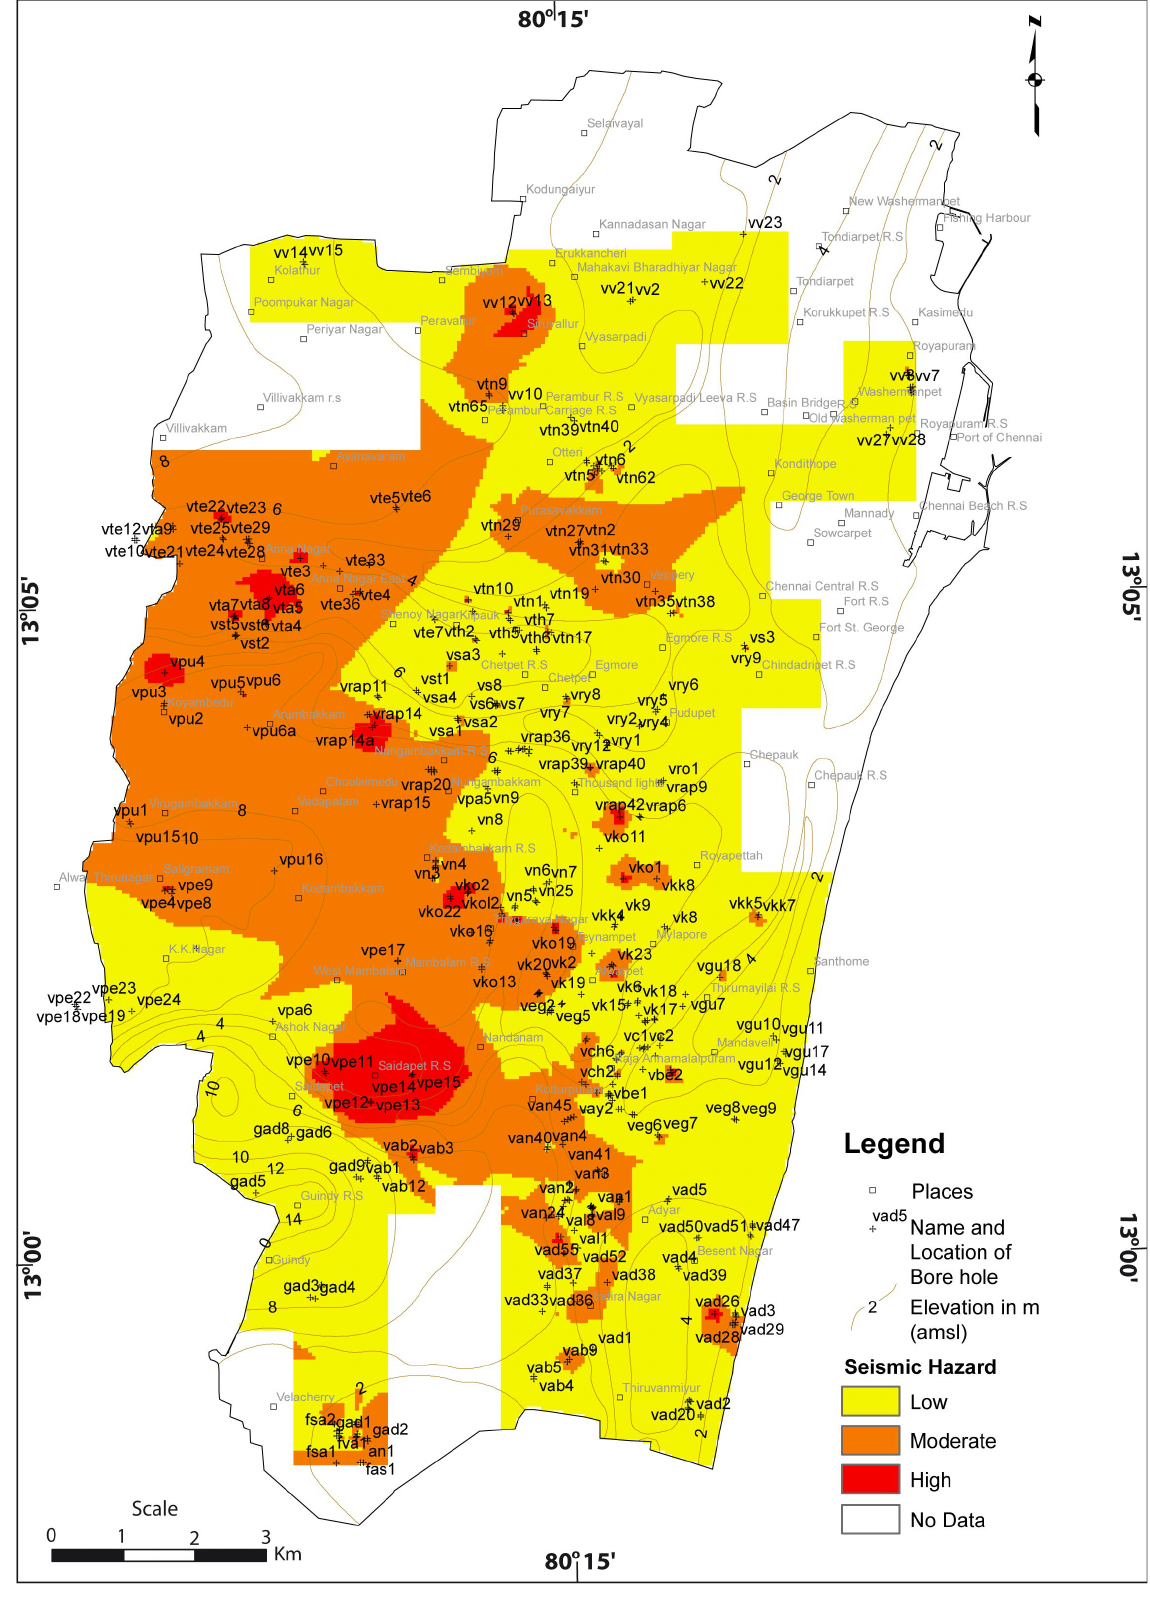
Fig. 8. First level seismic microzonation map of Chennai